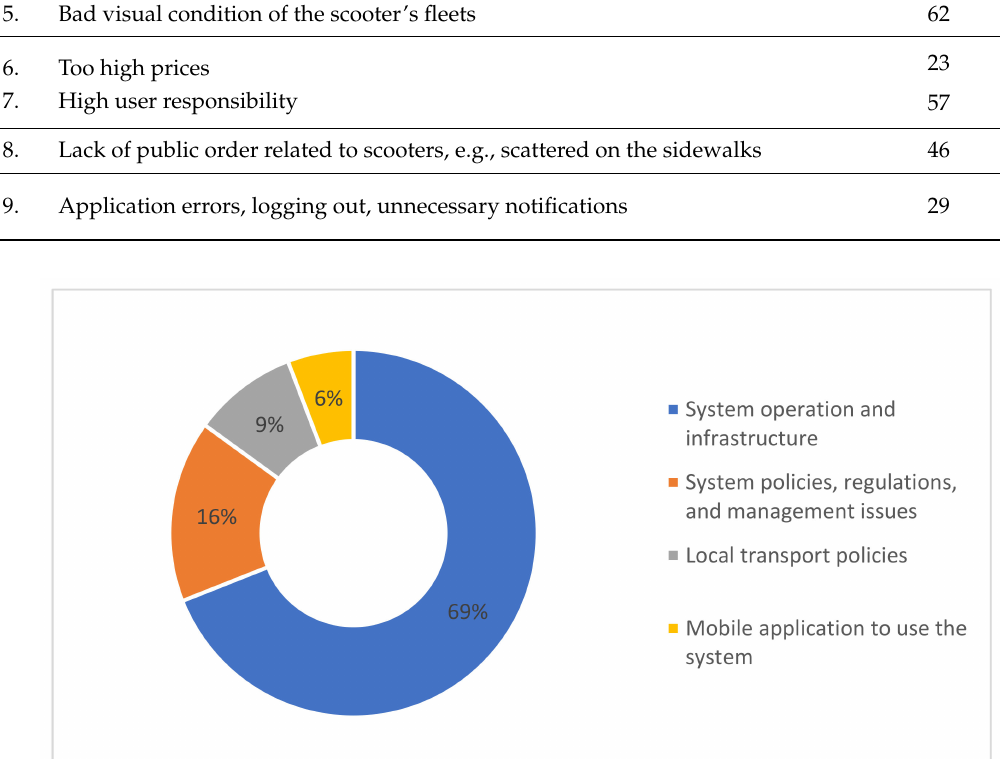
Figure 3. Percentage distribution of complaints areas in scooter-sharing